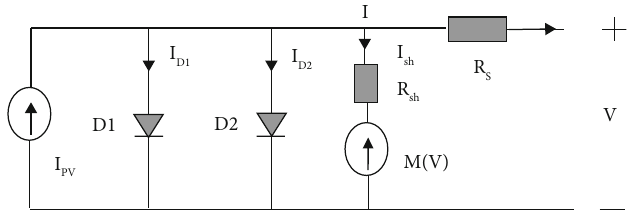
Figure 3: Solar cell equivalent